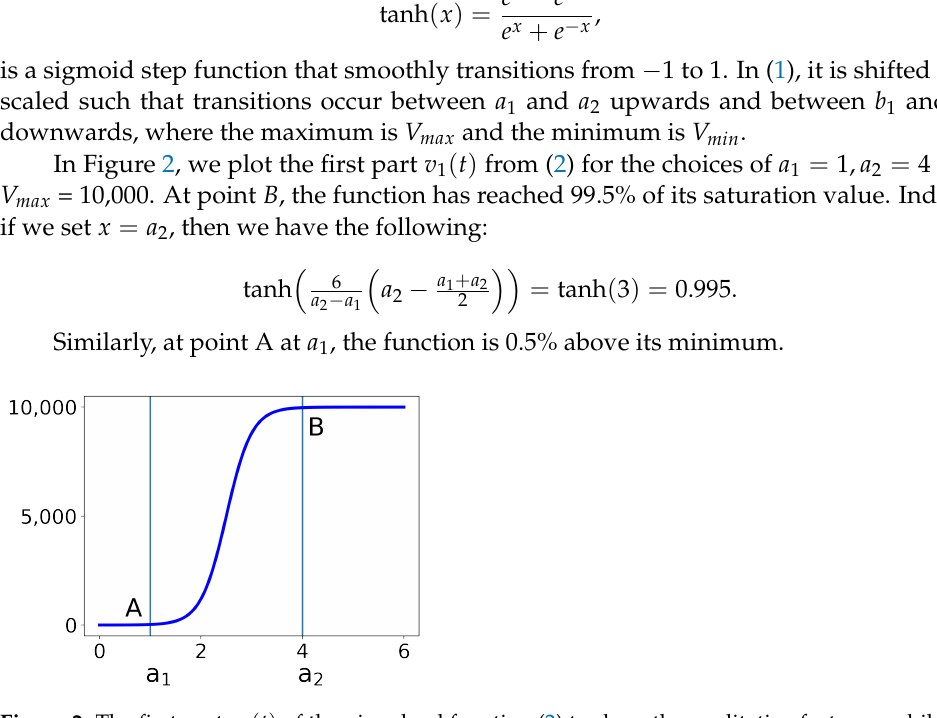
Figure 2. The first part v 1 ( t ) of the virus load function (2) to show the qualitative features, while the function transitions from 0 to V max between a 1 = 1 and a 2 = 4. At points A and B, it assumes 99.5% of the limit values on the left or the right,